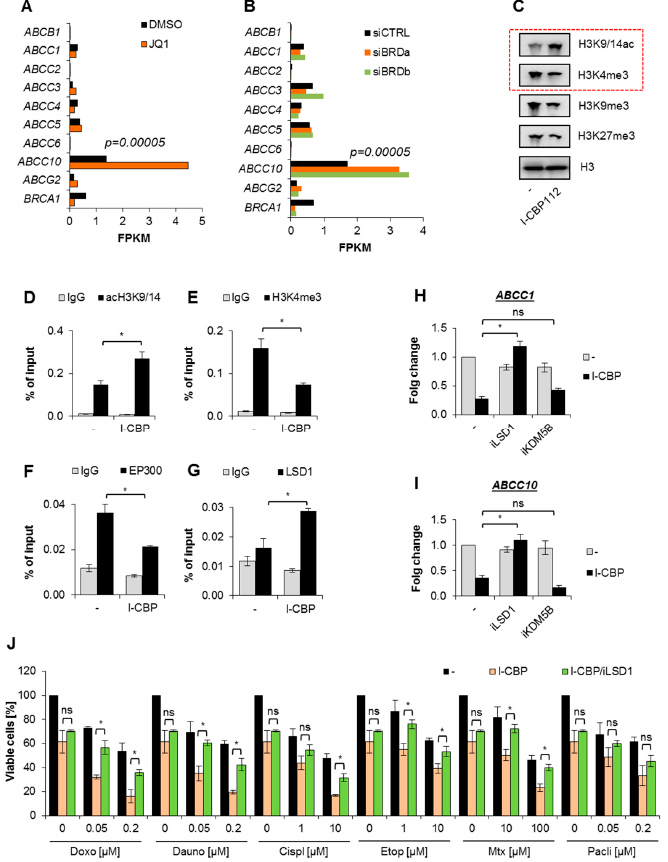
Figure 5. I-CBP112 reduced trimethylation of H3K4 and induced LSD1-mediated gene repression in MDA-MB-231 breast cancer cells. ( A , B ) The impact of BRD silencing and JQ1 (bromodomain inhibitor) on the mRNA levels of selected ABC transporters was determined by quantifying differ- ential gene expression (using TopHat for mapping, CuffLinks for transcript assembly, and CuffDiff for quantitative transcript comparison) based on publicly available data sets. Gene expression is presented as fragments per kilobase of transcript per million mapped reads (FPKM). ( C ) The effect of I-CBP112 (10 µ M; 72 h) on some histone modifications was evaluated in cell lysates by Western blotting. Transcription-promoting markers are highlighted using red dashed